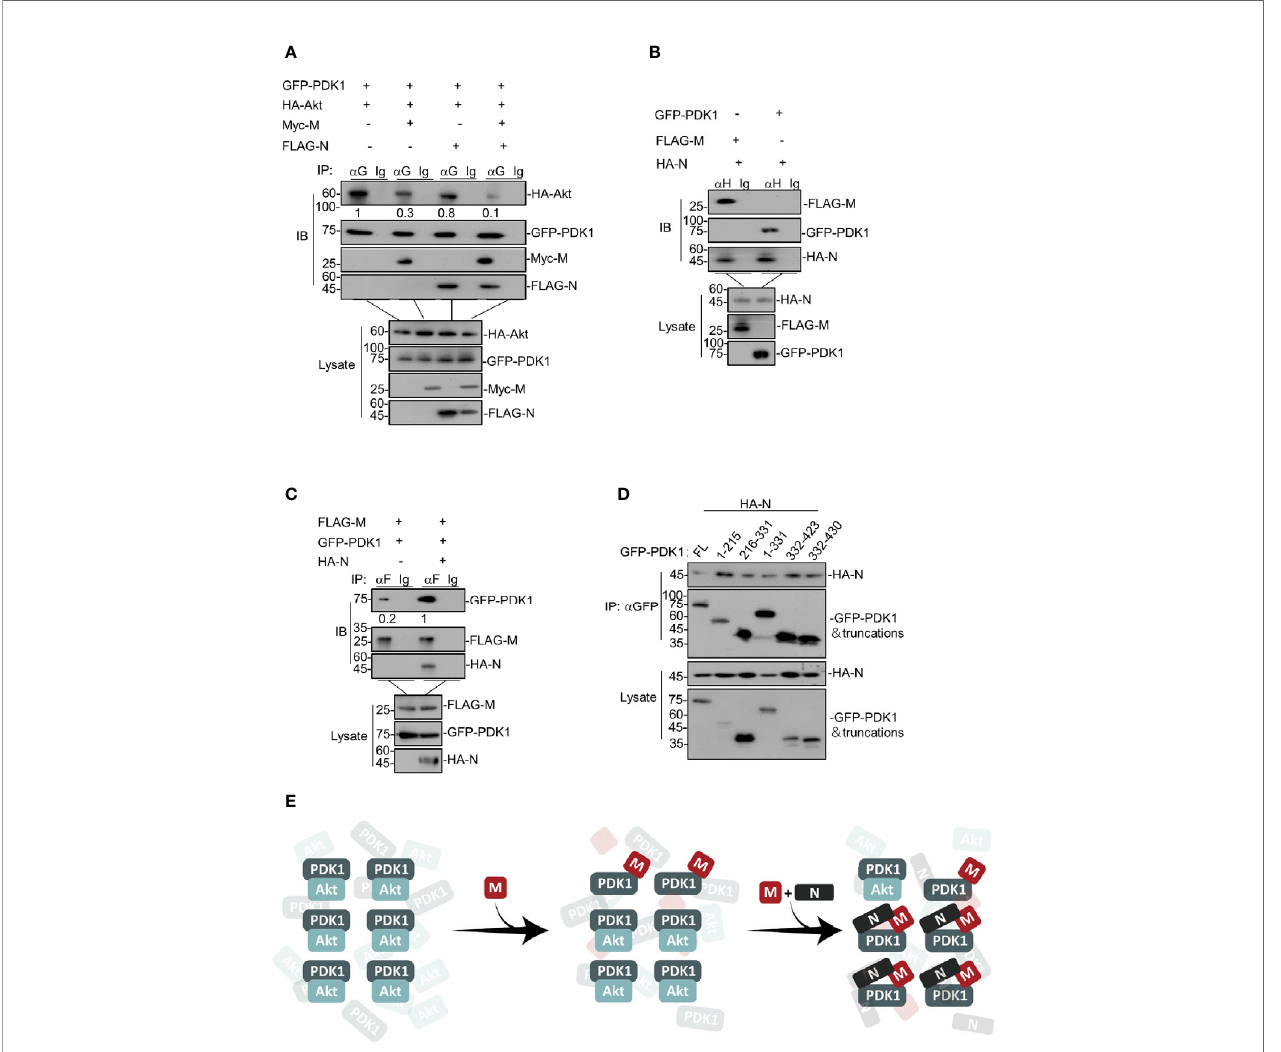
FIGURE 3 | SARS-CoV-2 N facilitates M to attenuate the PDK1-PKB/Akt interaction further. (A) HEK293T cells were transfected with GFP-PDK1 and HA-Akt together with Myc-SARS-CoV-2 M, FLAG-SARS-CoV-2 N, and Myc-SARS-CoV-2 M plus FLAG-SARS-CoV-2 N, respectively. After 24 h, cells were collected for co- immunoprecipitation (with anti-GFP or IgG) and Western blotting (with anti-GFP, anti-Myc, anti-HA, or anti-FLAG). (B) HEK293T cells transfected with HA-SARS- CoV-2 N together with FLAG-SARS-CoV-2 M and GFP-PDK1, respectively. After 24 h, cells were collected for co-immunoprecipitation (with anti-HA or IgG) and Western blotting (with anti-GFP, anti-HA, or anti-FLAG). (C) HEK293T cells were transfected with FLAG-SARS-CoV-2 M and GFP-PDK1 together with vector and HA-SARS-CoV-2 N, respectively. After 24 h, cells were collected for co-immunoprecipitation (with anti-FLAG or IgG) and Western blotting (with anti-GFP, anti-HA, or anti-FLAG). (D) HEK293T cells transfected with GFP-PDK1 and its truncations together with HA-SARS-CoV-2 N. After 24 h, cells were collected for co- immunoprecipitation (with anti-GFP) and Western blotting (with anti-GFP or anti-HA). (E) A model for SARS-CoV-2 N facilitating M to attenuate the PDK1-PKB/Akt interaction further. The densities of blots were analyzed with ImageJ